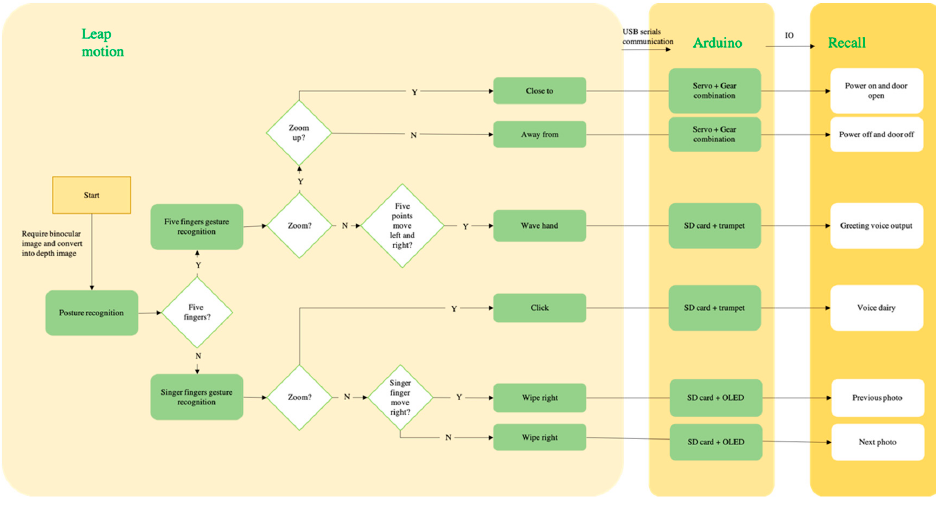
Figure 3. The flow diagram of display.